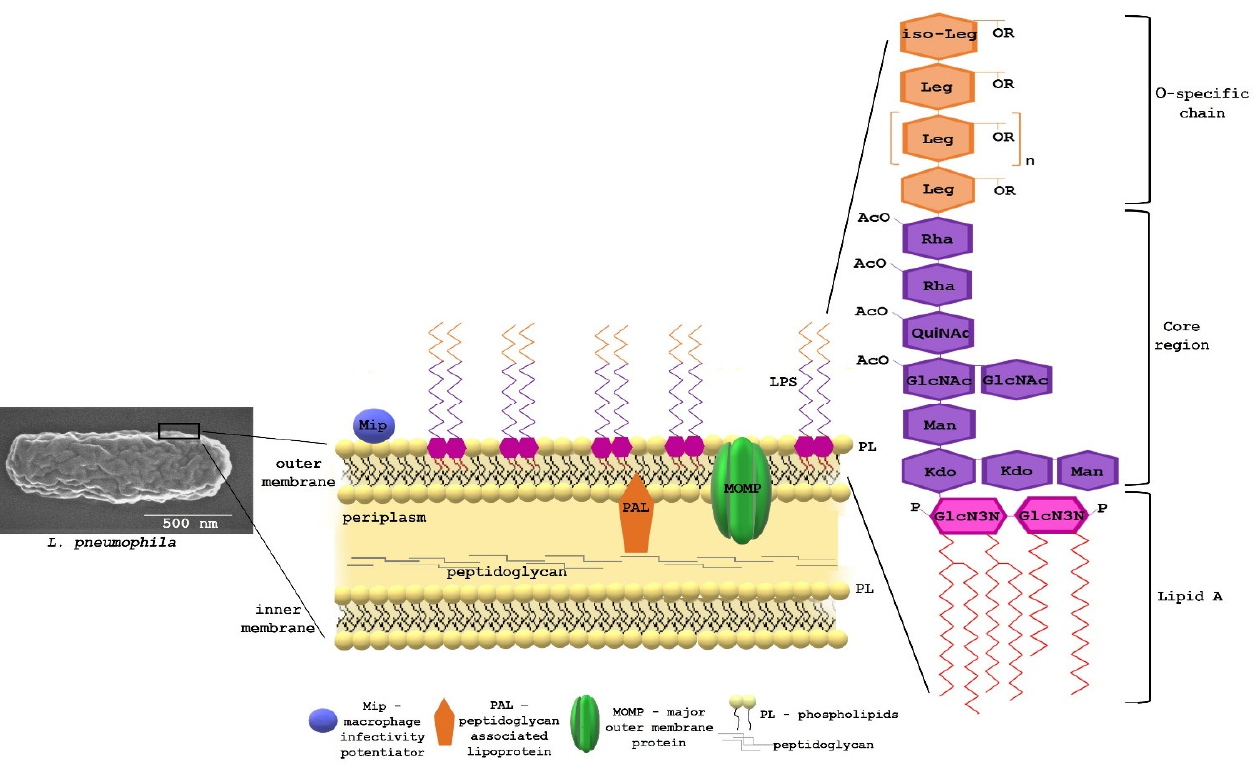
Figure 1. Scanning electron microscopy image of Legionella pneumophila , and model of the L. pneumophila cell envelope. Structure of lipopolysaccharide (LPS) (modified from [16]). Leg., legionaminic acid; Rha, rhamnose; OAc, O-acetyl; QuiNAc, acetylquinovosamine; GlcNAc, acetylglucosamine; Man, mannose; Kdo, 3-deoxy-d-manno-oct-2-ulosonic acid; P, phosphate; and GlcN3N, 2,3 diamino-2,3-dideoxy- D -glucose.